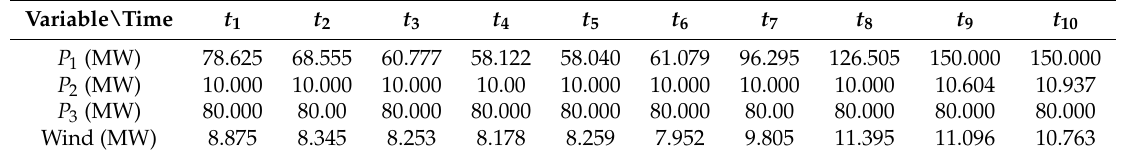
Table 5. Economic dispatch with ARMA scenarios.